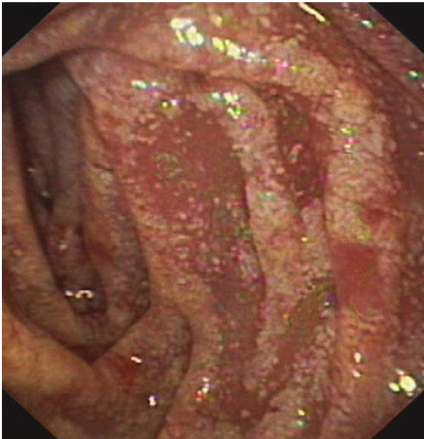
Figure 11: Whipple’s disease: control enteroscopy after two-month treatment. Detail view of the jejunal mucosa. Mucosa is still swollen with tiny granular pattern.